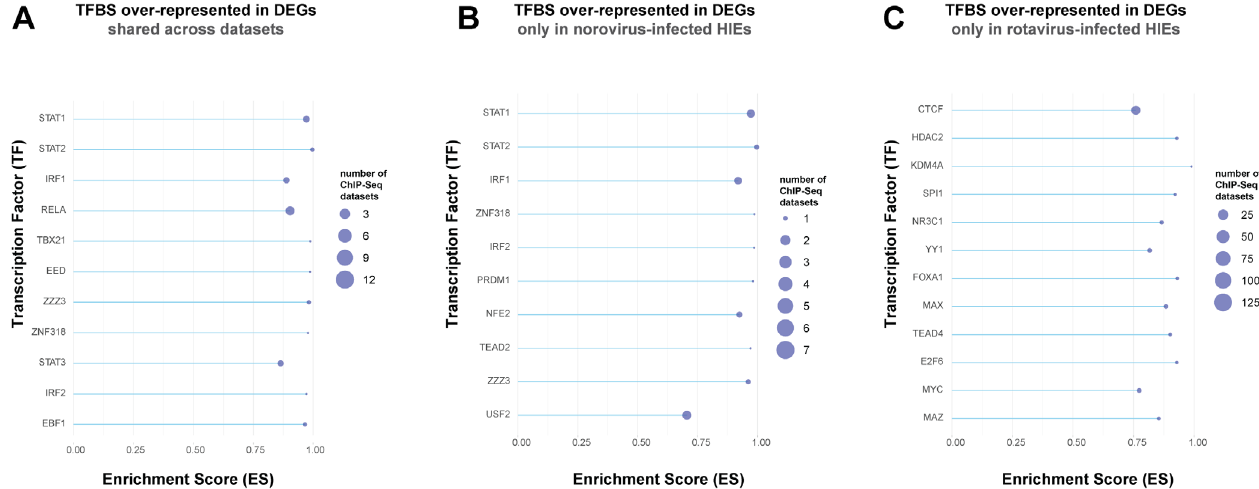
Figure 7. Transcription factor binding site (TFBS) analysis of differentially expressed gene sets (DEGs). Displayed are the enriched TFBS present in the list of 63 DEGs that were shared or partially shared across the three RNA-seq datasets (astrovirus, norovirus and rotavirus-infected HIEs) ( A ), the 47 DEGs only identified in norovirus-infected HIEs ( B ), and the 18 DEGs only identified in rotavirus-infected HIEs ( C ). Enrichment Score (ES) values are displayed for each transcription factor (TF) reflecting the degree to which a TF is significantly enriched (FDR-adjusted p value < 0.05) in the subset of DEGs as well as the number of ChIP-seq datasets used in the analysis of the TF. Transcription factor enrichment analysis (TFEA) was performed with the package TFEA.ChIP in R.